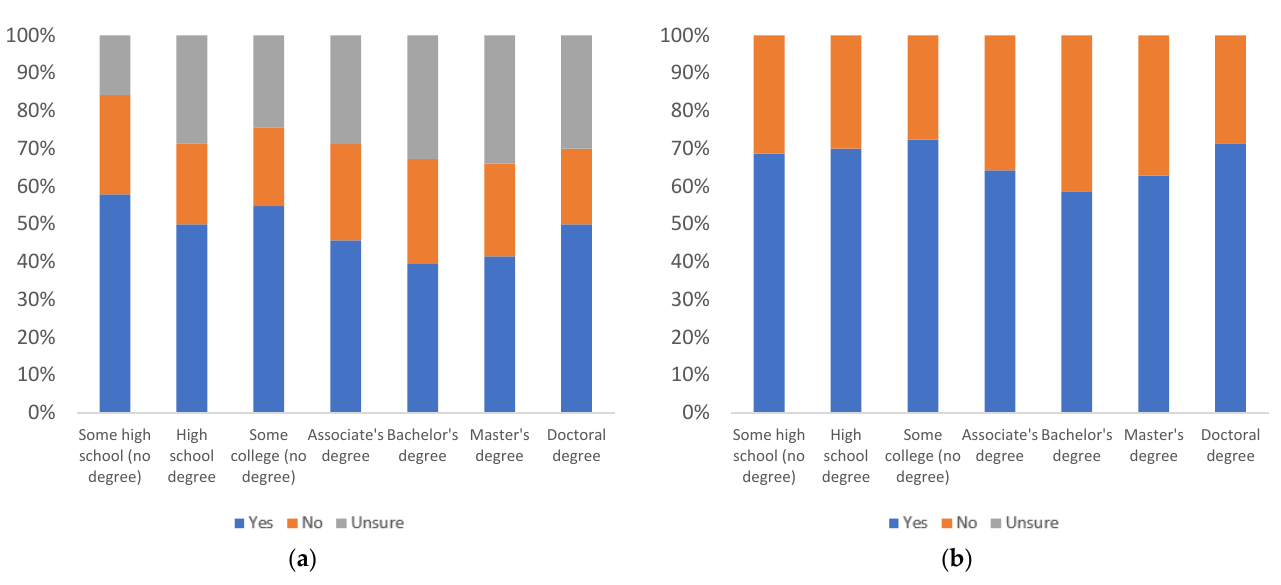
Figure 15. Label others’ use, by education level: ( a ) with uncertain respondents (left) and ( b ) without uncertain respondents (right).